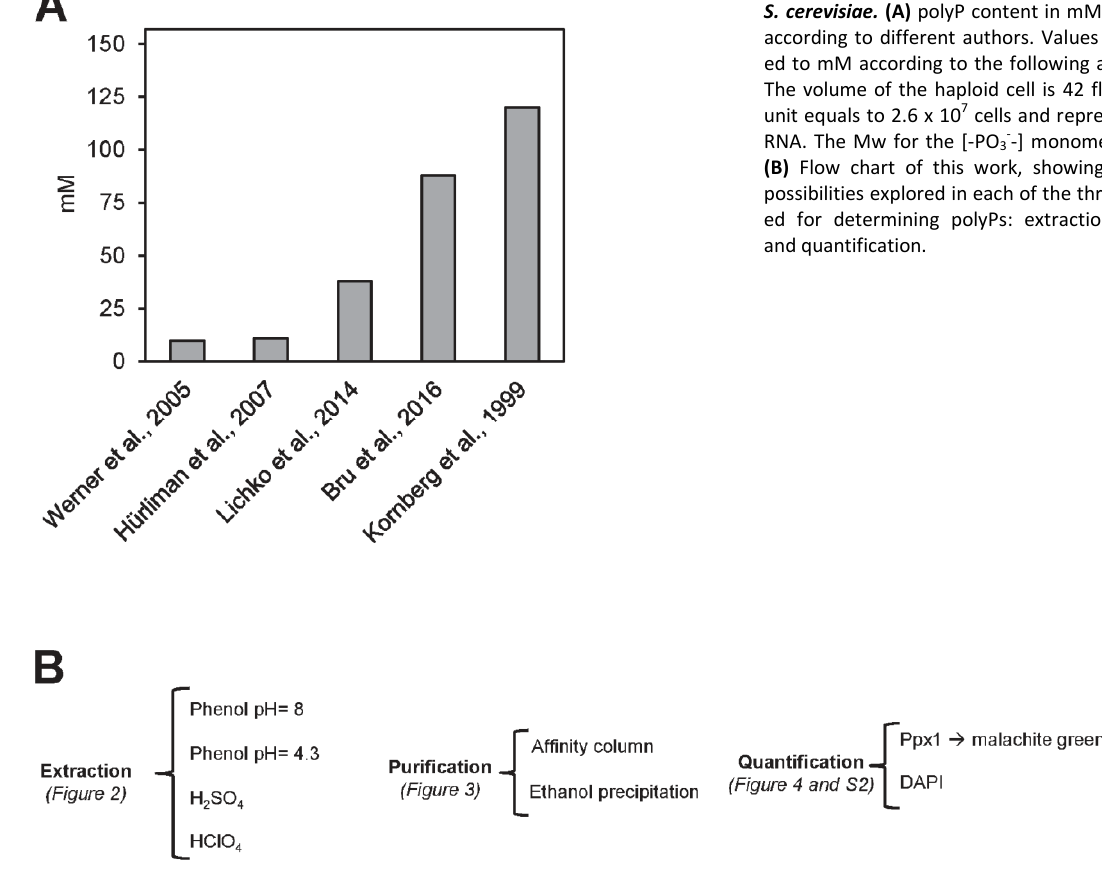
FIGURE 1: High variability on polyP determination